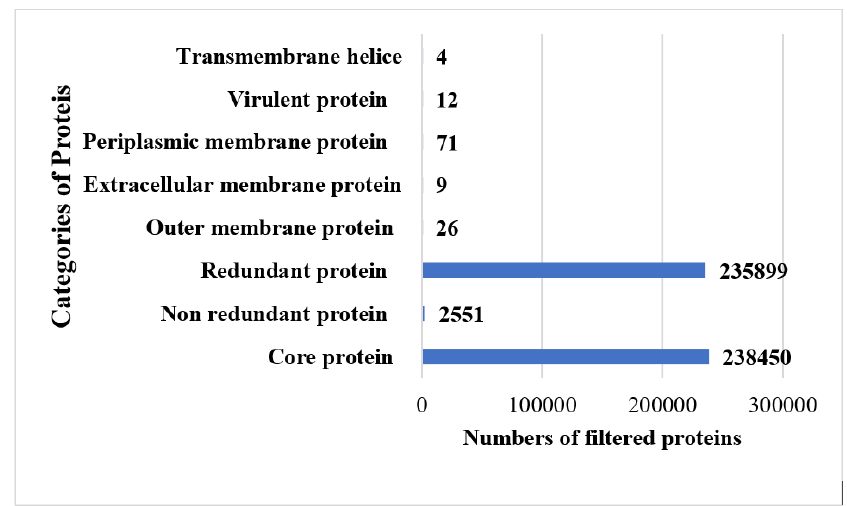
Figure 2. Shortlisted proteins in each step of subtractive proteomics filter.